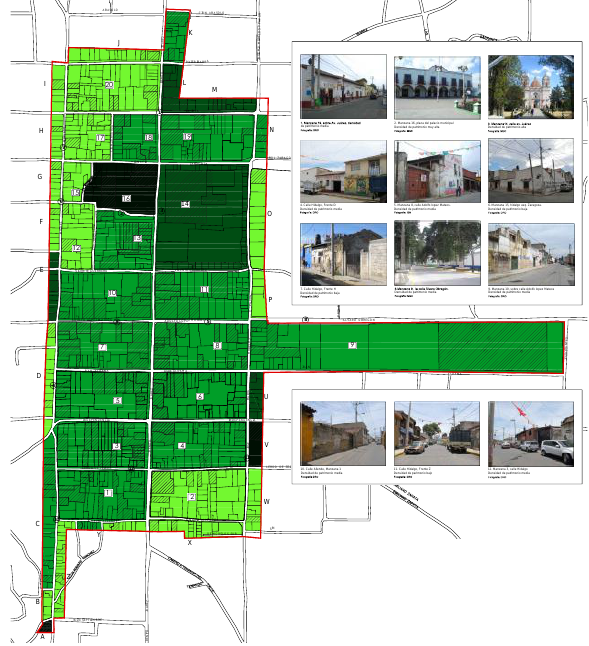
Figure 1. Heritage density level. (Source: own